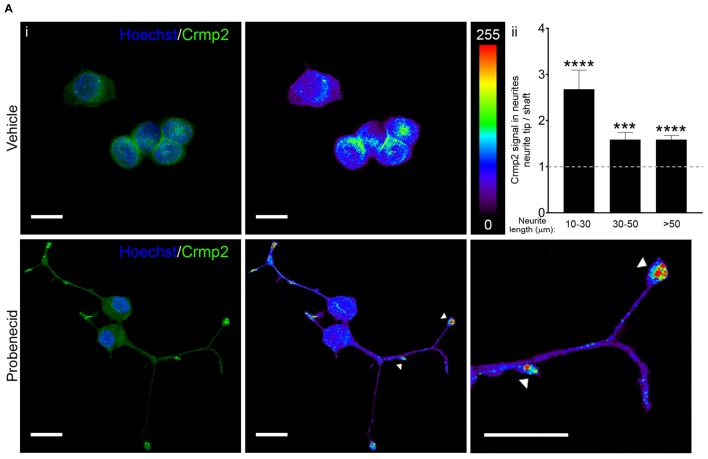
Probenecid treatment results in Crmp2 concentration at neurite tips. (Ai) Representative confocal images from N2a cells treated with vehicle (upper panels) or probenecid (lower panels) and immunostained for Crmp2. Crmp2 signal intensity is indicated in the heat maps. Hoechst 33342 was used as a nuclear counterstain. Scale bars: 20 μm. (ii) Crmp2 signal in probenecid-induced neurites was more abundant in neurite tips compared to the shaft, regardless of neurite length (10–30 μm, p < 0.0001, n = 38 neurites; 30–50 μm, p = 0.0003, n = 40 neurites; >50 μm, p < 0.0001, n = 48 neurites; Wilcoxon signed-rank test against a hypothetical median value of 1.0).